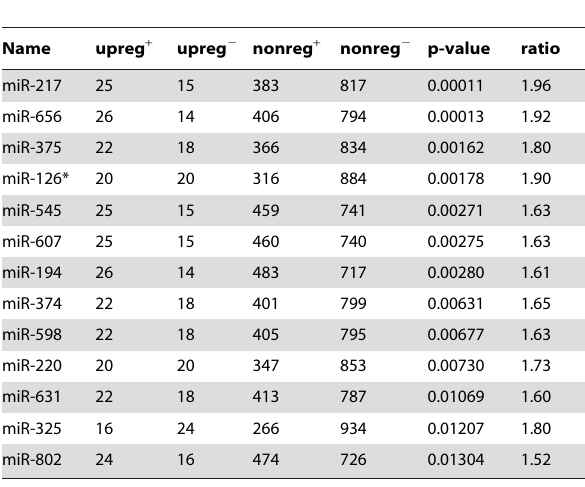
List of miRNAs with positive selection (accumulation of binding sites) among 40 highly eIF4E upregulated mRNAs (fold change greater 4.0) and 1200 nonregulated mRNAs (fold change between 1.05 and 1.0/1.05). See caption of Table 5 for an explanation of table